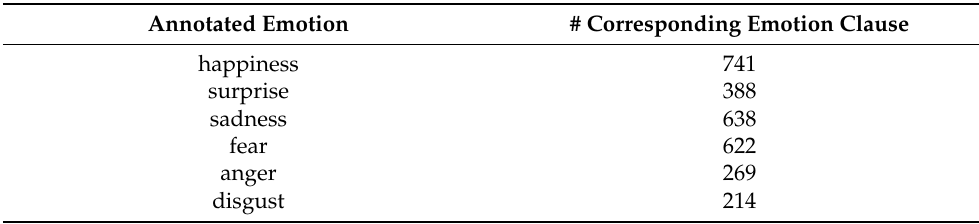
Table 2. The distribution of emotion clauses corresponding to the six annotated emotions in the